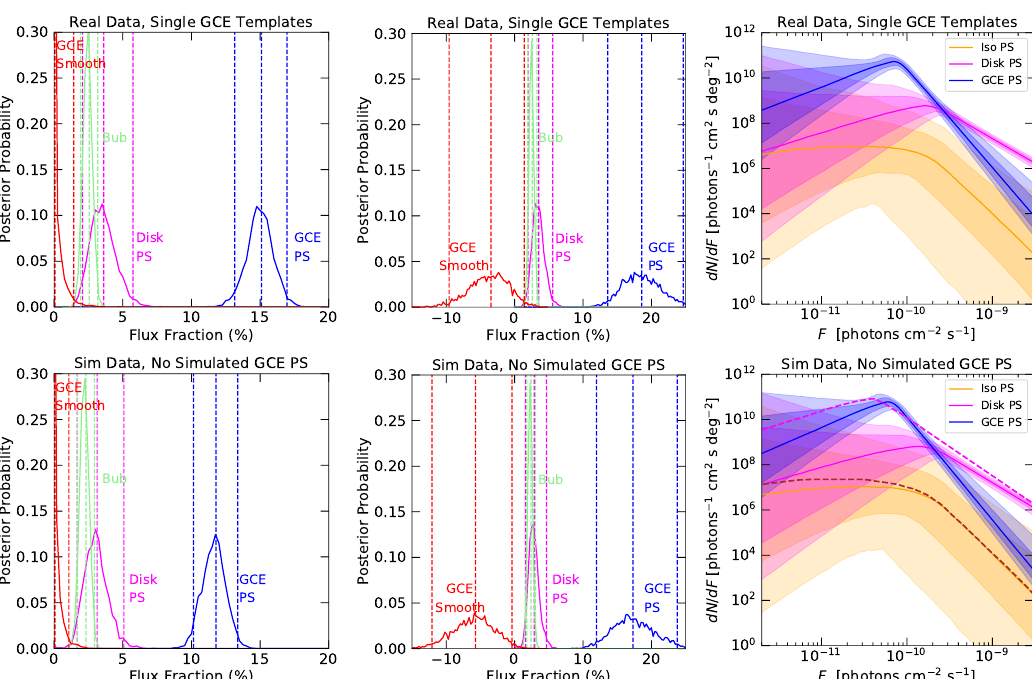
Figure 18: Comparison of real ( top row ) and simulated ( bottom row ) data; in all cases the analyses used symmetric GCE templates (smooth and point sources). The simulated dataset contains a smooth asymmetric GCE and no GCE point sources. Left column: Flux posteriors for various templates in the fit where the GCE Smooth component is constrained to have positive coefficient. Middle column: Flux poste- riors for various templates in the fit where the GCE Smooth component is allowed to float to negative values. Right column: SCF corresponding to the left column. The dashed lines on the bottom SCF plot are the simulated SCF for Disk PS (pink) and Iso PS (brown). Reproduced from Ref. [ 251 ]